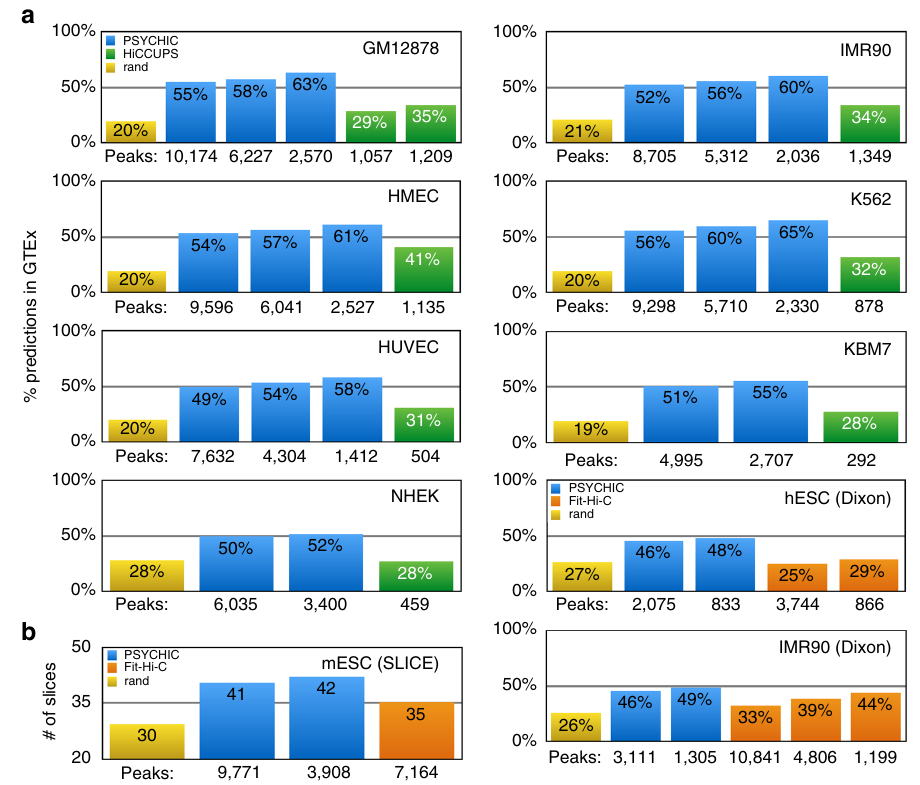
Fig. 6 PSYCHIC predictions are enriched for eQTLs and ultra-thin nuclear cryo-sectioning slices. a The majority of PSYCHIC ’ s promoter – enhancer interactions are supported by eQTL data from the Genotype-Tissue Expression (GTEx) Project 63 . Shown is a comparison of the percentage of predicted interactions using various methods with eQTL data, including random promoter-proximal interactions (yellow), PSYCHIC predictions (blue, using FDR thresholds of 1e-2 and 1e-4. Results with FDR < 1e-10 are also shown for fi rst 5 cell lines), HiCCUPS 19 (green), or Fit-Hi-C 62 (orange; q value thresholds of 1e-10, 1e-20, and for IMR90 also 1e-40), for various cell lines and tissues in human and mouse. Below each bar, we mark the number of predicted promoter – enhancer interactions. b Comparison of random (yellow), PSYCHIC (blue; FDR < 1e-2 and FDR < 1e-4) and Fit-Hi-C 62 (orange; q value < 1e-20) predictions, with regard to the sequencing of genomic DNA content in ultra-thin cryo-sectioning slices in mES cells 64 . Y -axis marks the number of slices in which both the enhancer and the promoter regions were